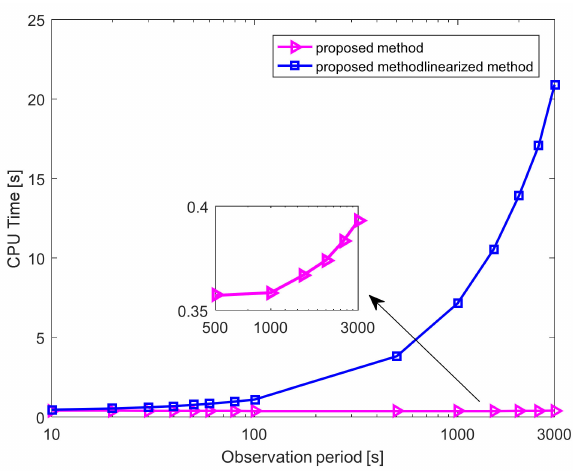
Figure 11. The CPU times of the linearized method and the stellar angle measurement-aided phase estimation